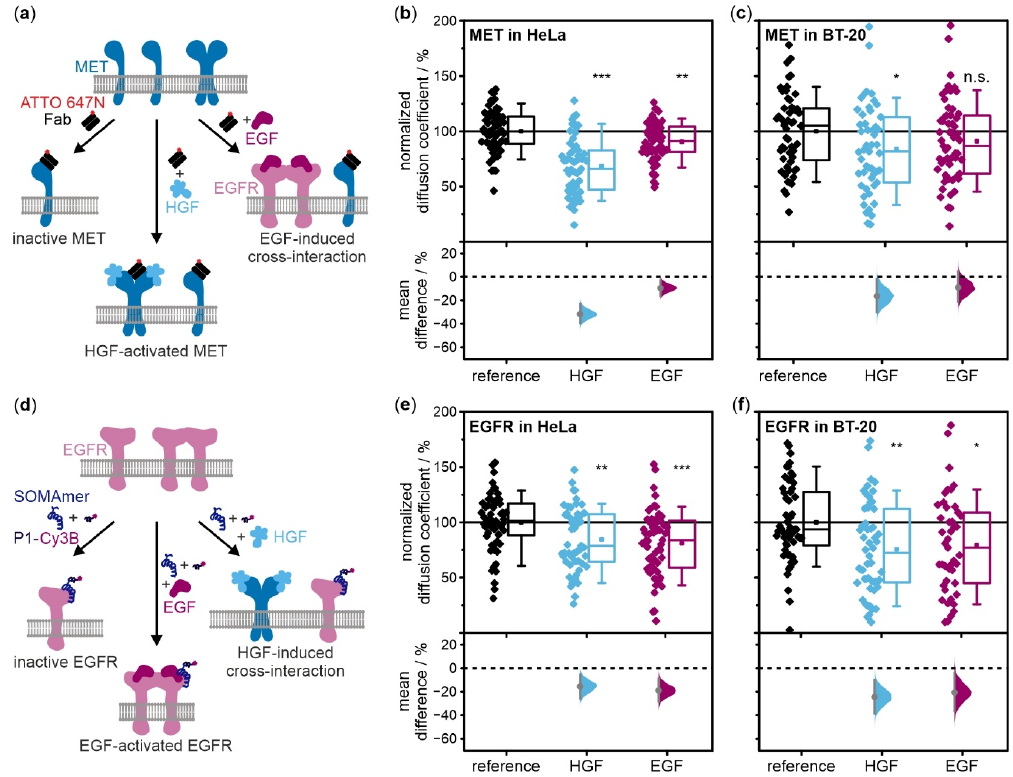
Figure 3. Diffusion dynamics of MET and EGFR in HeLa and BT-20 cells after stimulation with HGF and EGF studied by SPT indicate receptor cross-interactions. ( a , d ) MET was tracked by adding Fab-ATTO 647N. EGFR was tracked by adding EGFR-SOMAmer reagent modified with a P1-docking strand and P1-Cy3B for PAINT imaging. The Fab fragment and the SOMAmer reagent bind to the respective receptor but do not activate them. For observations of direct activation or possible cross-interaction, unlabeled HGF (light blue) or EGF (purple) were added to the samples. Diffusion coefficients of MET and EGFR in resting and activated cells (each n = 50 from at least three independent experiments) were determined in ( b , e ) HeLa and ( c , f ) BT-20 cells. All diffusion coefficients were normalized against reference measurements of ligand-untreated cells for all types of treatment. The box plots of diffusion coefficients display the 5 th percentile, 25 th percentile, median (line), mean (square), 75 th percentile, and 95 th percentile. Results of two-sample t-tests for comparison of ligand-treated cells with the reference are depicted above the box plots ( p > 0.05 no significant difference between populations (n.s.), p < 0.05 significant difference (*), p < 0.01 very significant difference (**), p < 0.001 highly significant difference (***)). The lower y-axes of the graphs depict the distribution of mean differences [34] of each condition in comparison to the unstimulated sample. The mean difference is represented as a grey dot; each 95% confidence interval of the mean difference distribution is indicated by vertical grey error bars.